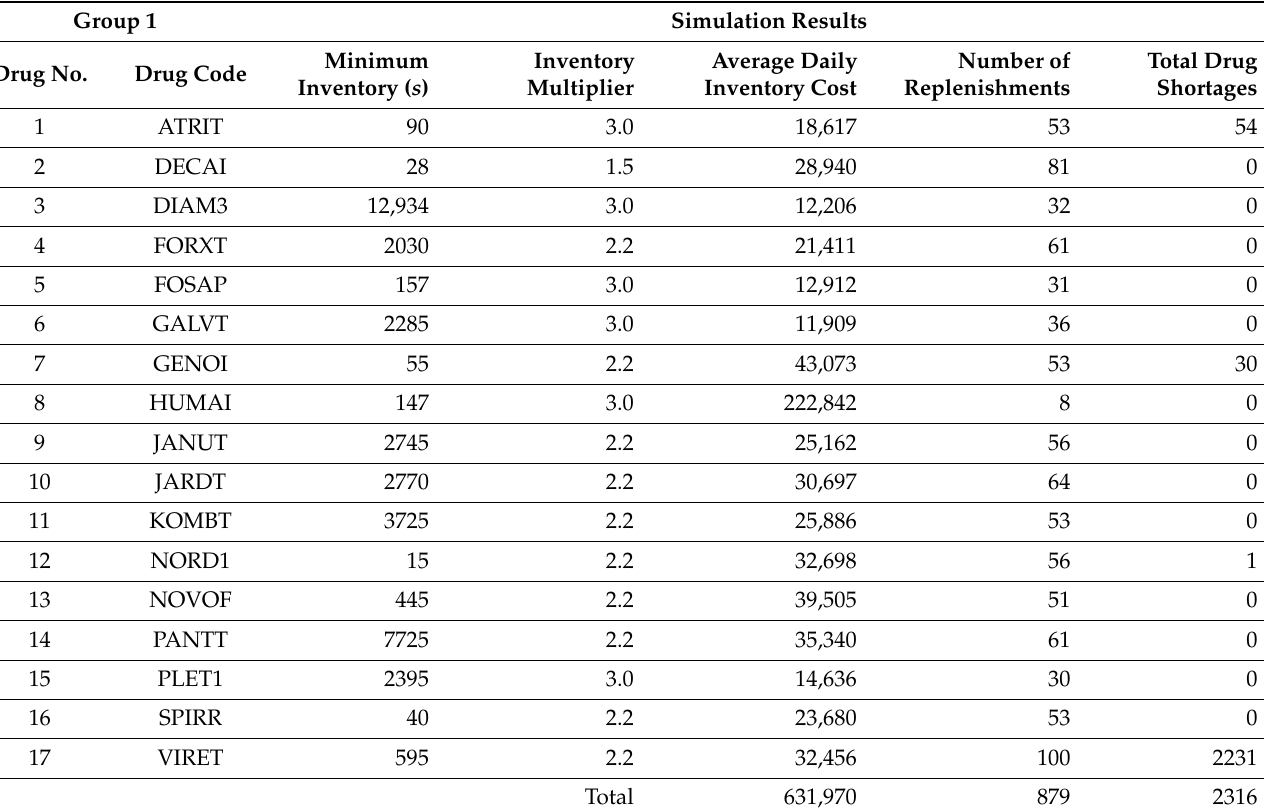
Table 2. Results for 17 drugs in Group 1 for Scenario